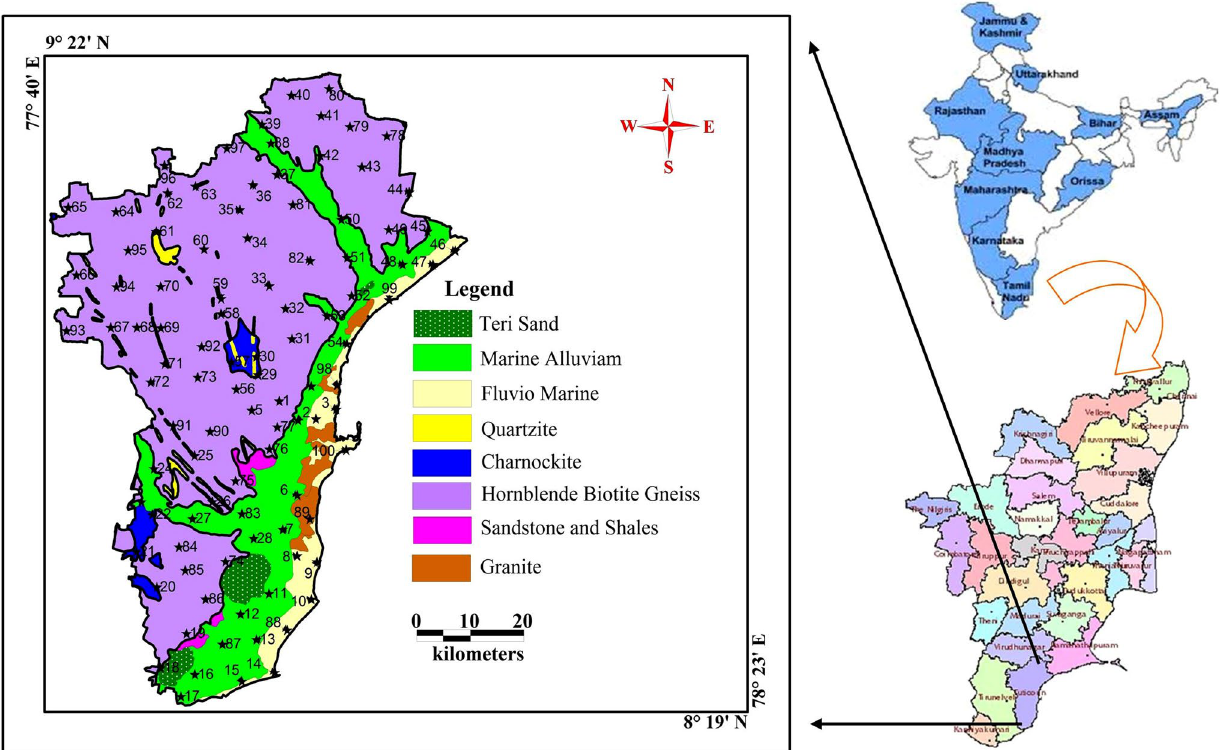
Fig. 1 Location and geology map of the study